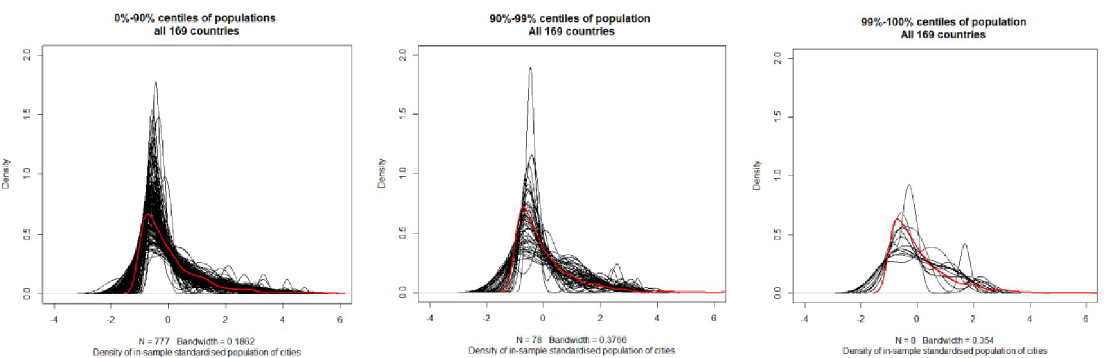
Fig 5. Consistency of empirical population distribution (standardised in subgroups) with gamma (1,1) distributions: a) 0–90% centiles, b) 90–99% centiles, c) 99–100% centile. Note: in countries with less cities, top centiles have just few observations, which are not plotted as distribution. Source: Own study with the use of R software.